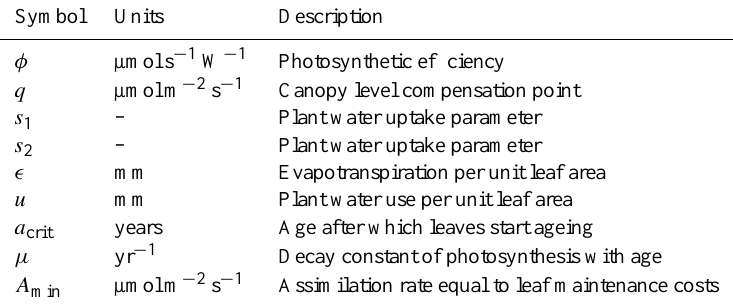
Table 3. Model parameters for leaf loss